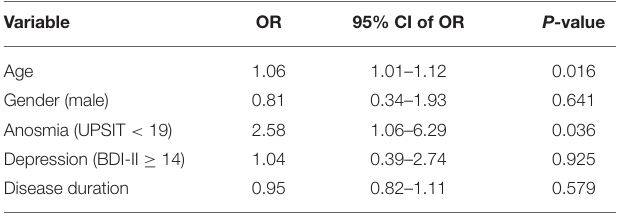
TABLE 2 | Relationship between depression and cognitive impairment.